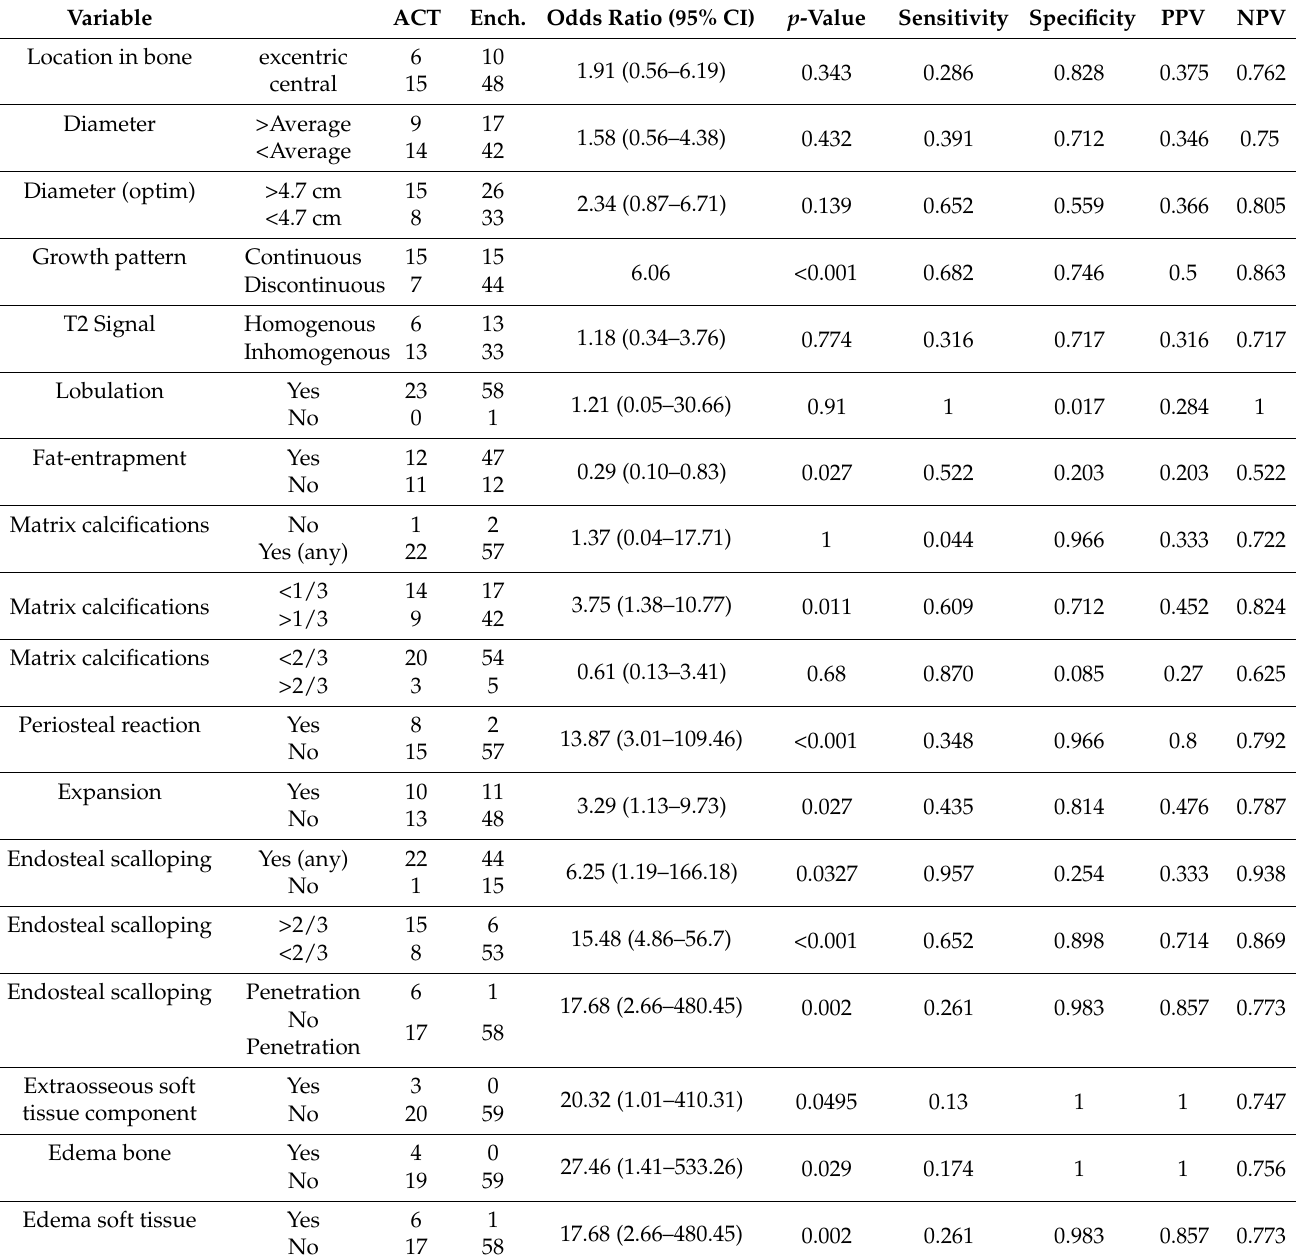
Table 1. Analysis of features assessed on MR and CT